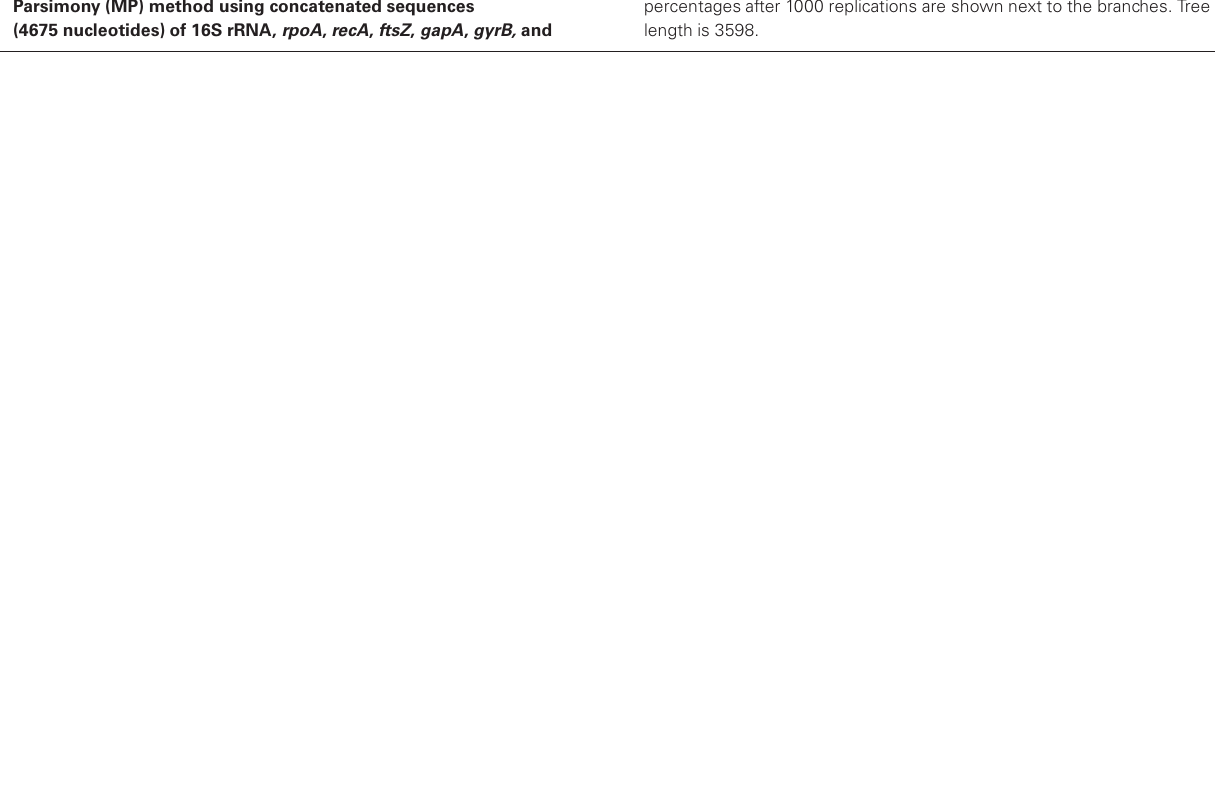
FIGURE A1 | Phylogenetic tree based on the Maximum Parsimony (MP) method using concatenated sequences (4675 nucleotides) of 16S rRNA, rpoA , recA , ftsZ , gapA , gyrB, and